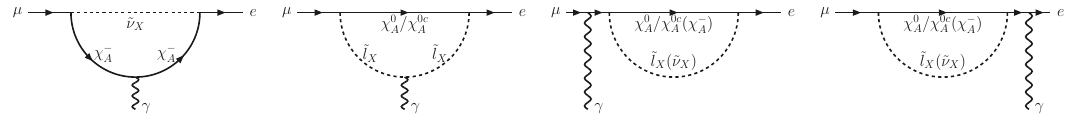
Figure 1. The four types of diagrams contributing to the photon interaction (3.4). All four diagrams contribute to the charge radius form factors A (cid:22) e(cid:22) L = R dipole form factors A (cid:22) e(cid:22) L = R